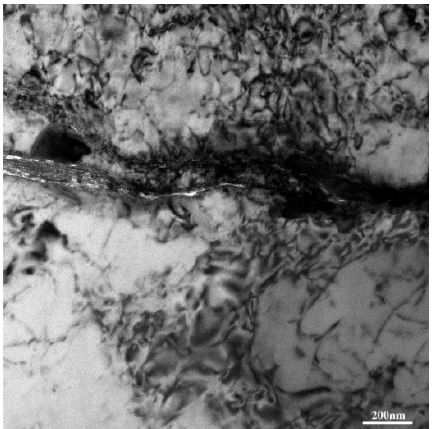
Figure 10. TEM image of dislocation in the composite fabricated .